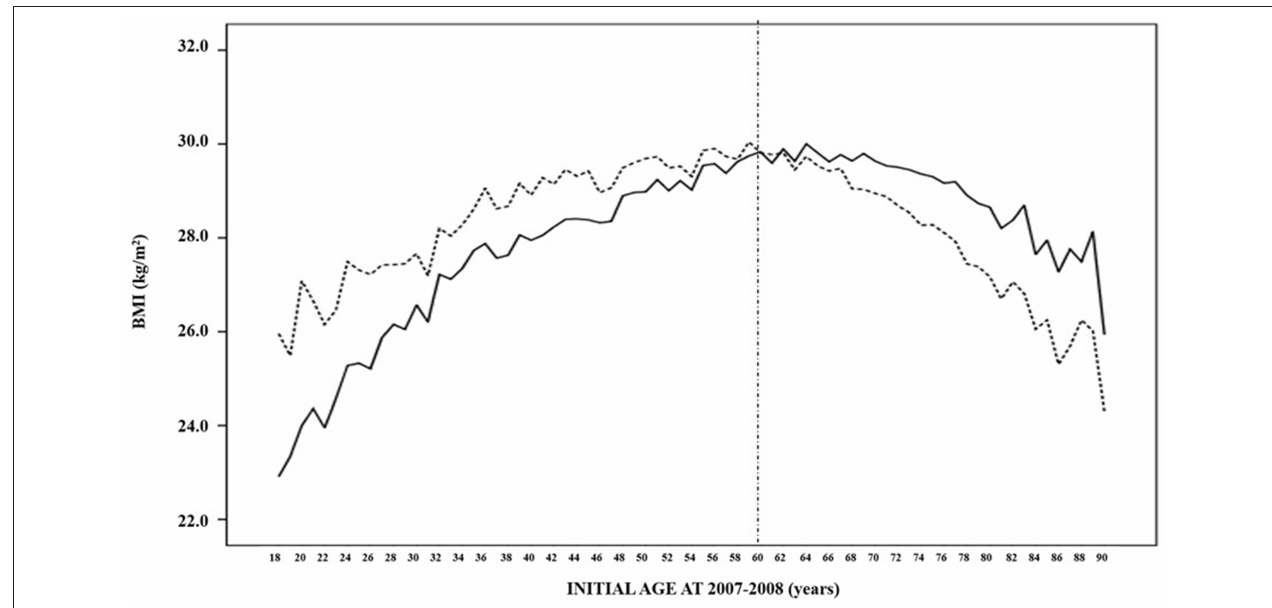
FIGURE 1 | Mean BMI distribution of the 50,019 subjects in the 2007–2008 (solid line) and 2017–2018 (dashed line) paired periods according to their age at the first evaluation. − 44.988 + (0.503 × age) + (10.689 × sex) + (3.172 × BMI) – (0.026 × BMI 2 ) + (0.181 × BMI × sex) – (0.02 × BMI × age) – (0.005 × BMI 2 × sex) + (0.00021 × BMI 2 × age), where